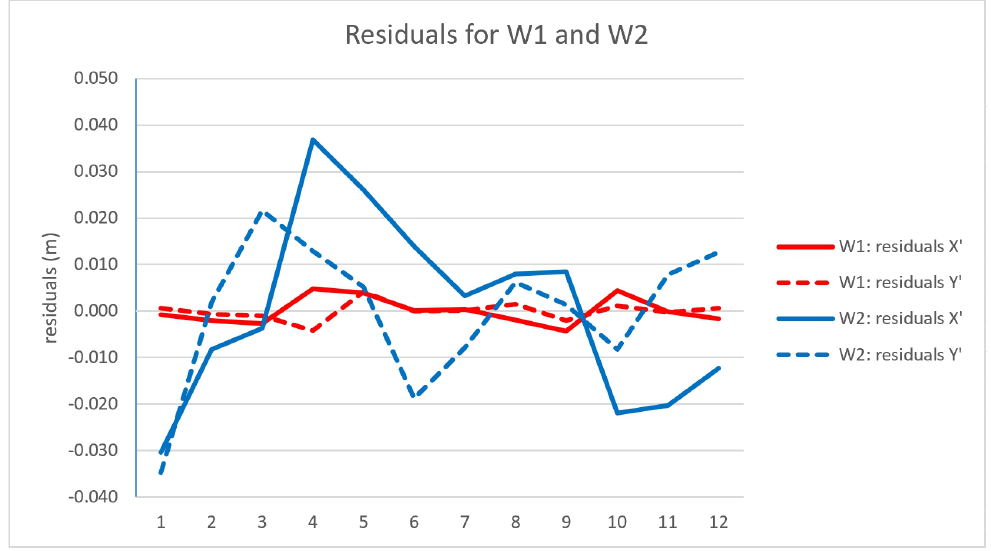
Figure 12. Residuals in meters for the different